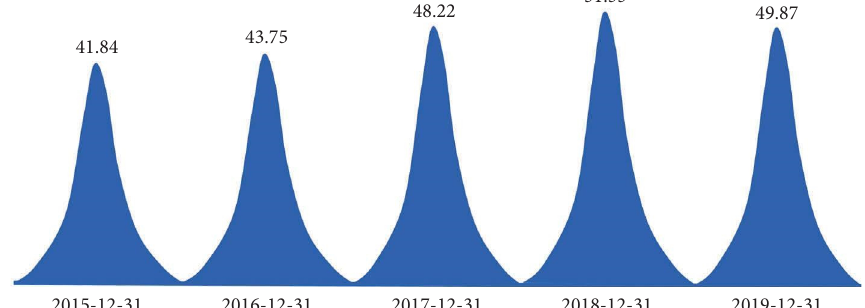
Figure 5: A company’s operating income from 2015 to 2019.